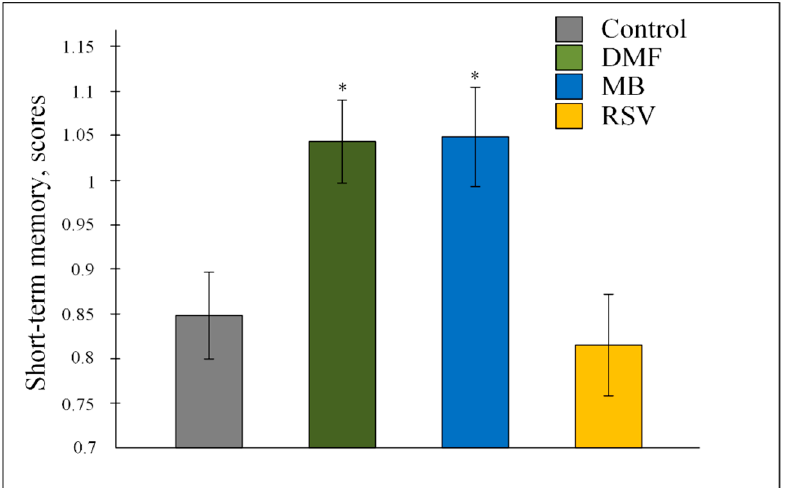
Figure 2. Number of scores in the Water Marris Maze for the assessment of short-term memory. The results expressed as means ± SEM. Control n = 8, DMF = 9, MB = 6, RSV = 7. * p < 0.05, comparison of control group and treated groups using Tukey’s post-hoc test. The studied compounds did not affect the distance and time that mice spent for the